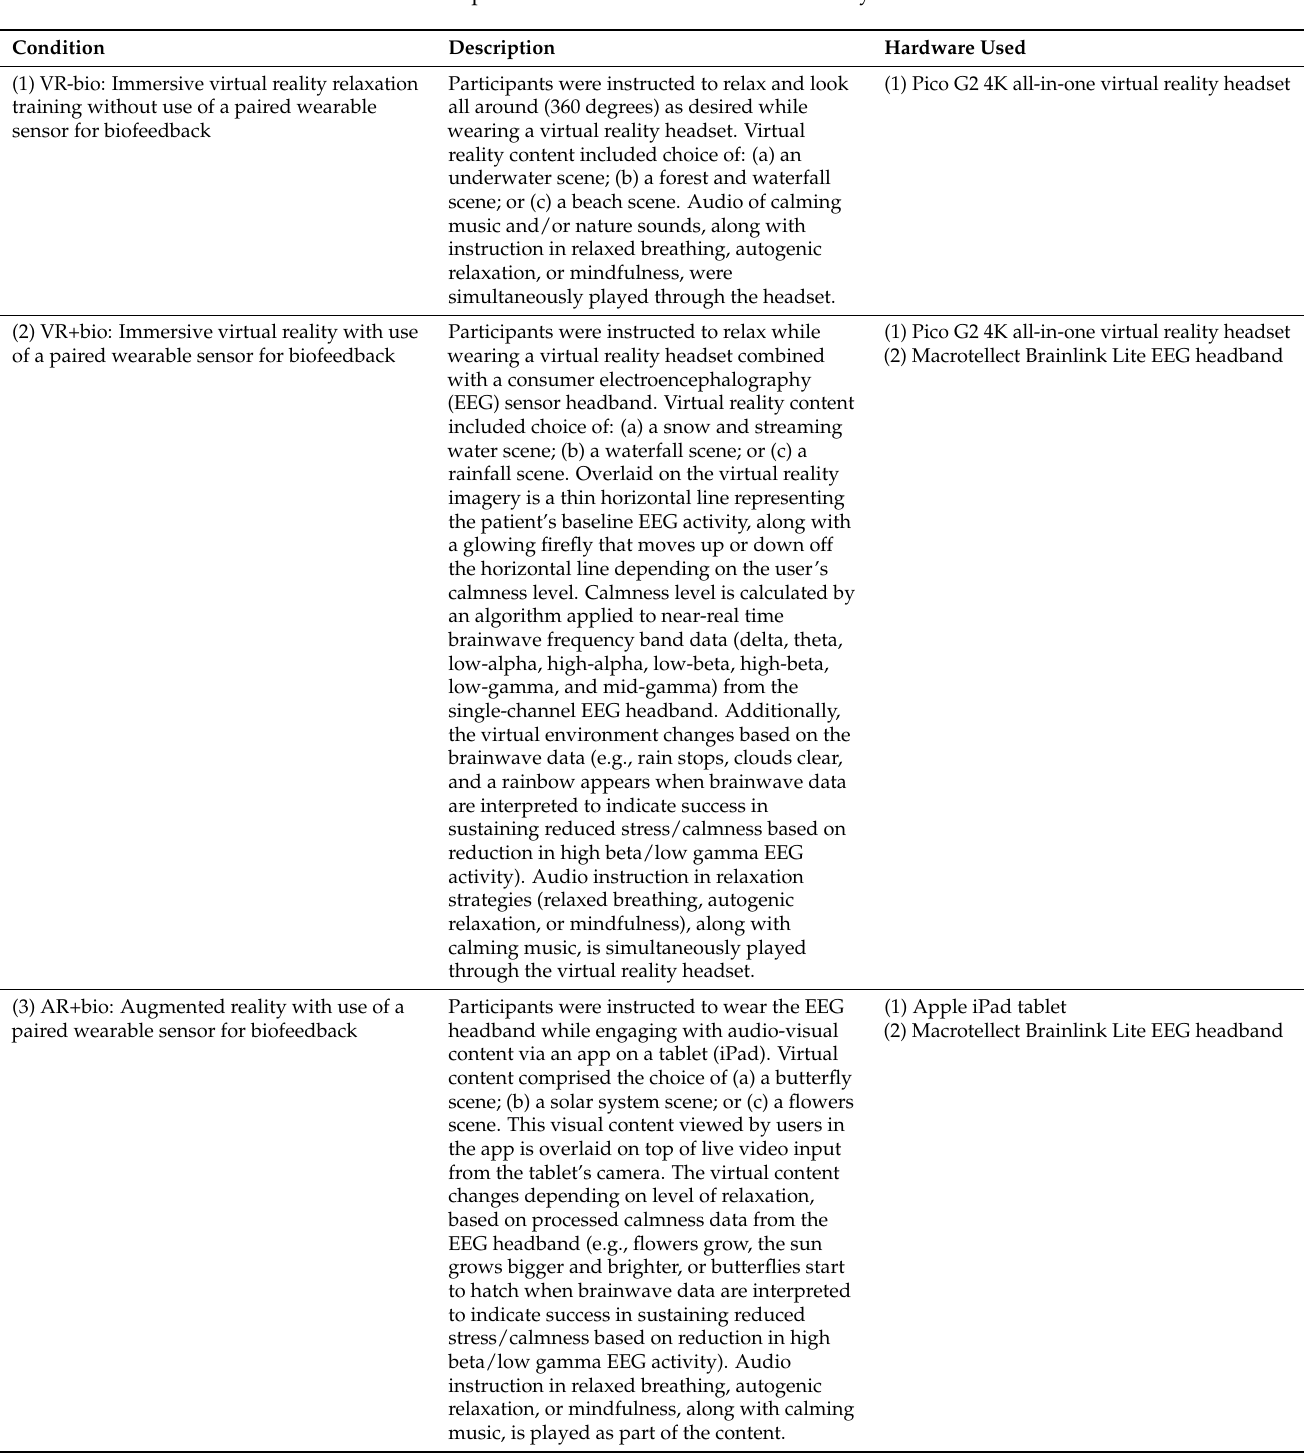
Table 1. Description of XR conditions used in the